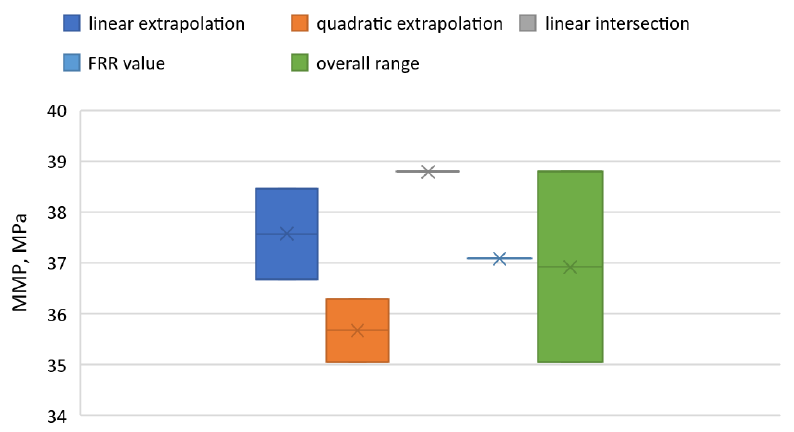
Figure 9. Summary of the results of the MMP calculation.